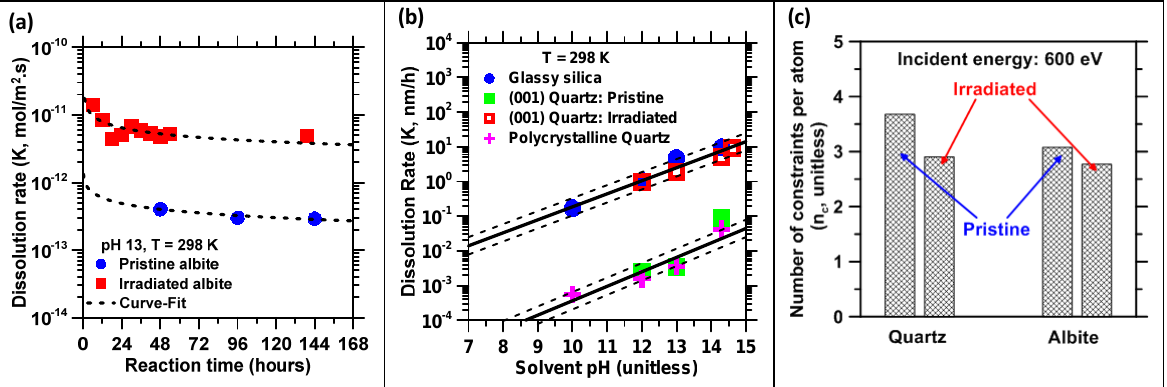
Figure 3. (a) A representative comparison of the dissolution rates of pristine and irradiated albite assessed using VSI as a function of time at pH 13 and 298 K. The dissolution rate of irradiated albite is nearly 20x higher than that of pristine albite as estimated from the change in the number of constraints of albite, following irradiation [38]. (b) The dissolution rate as a function of the solution pH for SiO 2 ‐ based solids including fumed silica, (001) surfaces of pristine and irradiated α‐ quartz, and polycrystalline α‐ quartz measured using VSI at 298 K [24]. The dissolution rate of α‐ quartz shows only slight sensitivity to surface orientation. The measured data are fitted by an equation of the form: K = A ∙ exp(±B ∙ pH), where A and B are numerical constants (the bold line shows fits, while the dashed lines show the uncertainty in the measurements). (c) The evolution of the average number of atomic constraints (n c ) in α‐ quartz and albite for an incident energy of 600 eV [24,26 ] as the minerals transition from their pristine (initial) to irradiated (final, disordered)